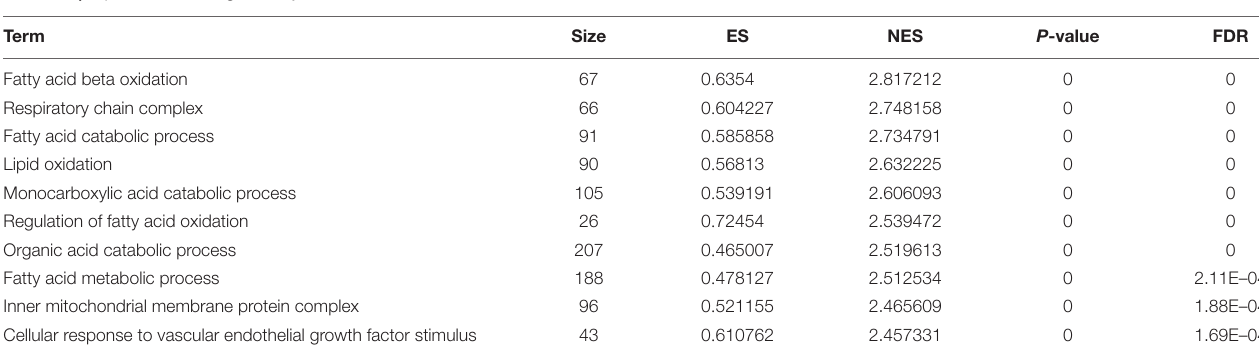
FIGURE 6 | Crtc1 deficiency globally remodels lipid metabolism in adipose tissue. (A) Schematic of the transcriptome analysis procedure. (B) Hierarchical clustering showing the relationship among different groups at the transcriptome level. (C) PCA plot showing global sample distribution profiles. (D) Volcano plot of DEGs (red, upregulated genes; blue, downregulated genes) in eWAT under the cut-off value of | log2 (fold change) | > 1 and P < 0.01. (E) Heatmap of the top 50 most significant DEGs in eWAT. (F) Bubble plot of lipid-metabolism-related biological processes ( P < 0.05) in eWAT by GO enrichment analysis. TABLE 2 | Top 10 GO term significantly enriched in GSEA of